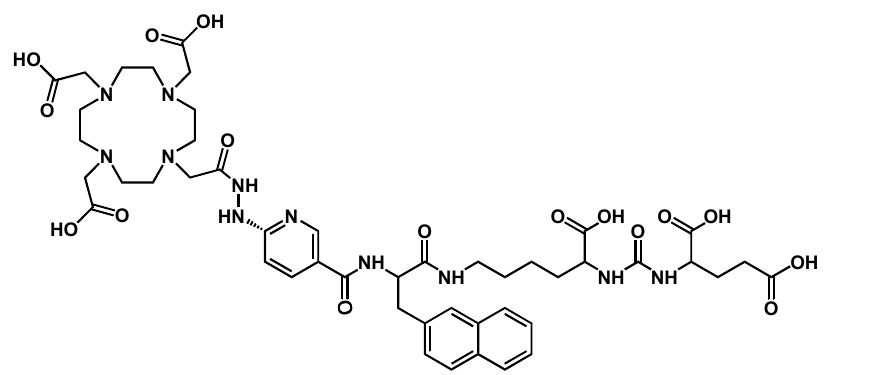
Figure A2. Chemical structure ((1-carboxy-5-(3-(naphthalen-2-yl)-2-(6-(2-(2-(4,7,10-tris (carboxymethyl)-1,4,7,10-tetraazacyclododecan-1-)acetyl)hydrazinyl)nicotinamido)propanamido)pentyl)carbamoyl)glutamic acid (DOTA − iPSMA: iPSMA) [31].